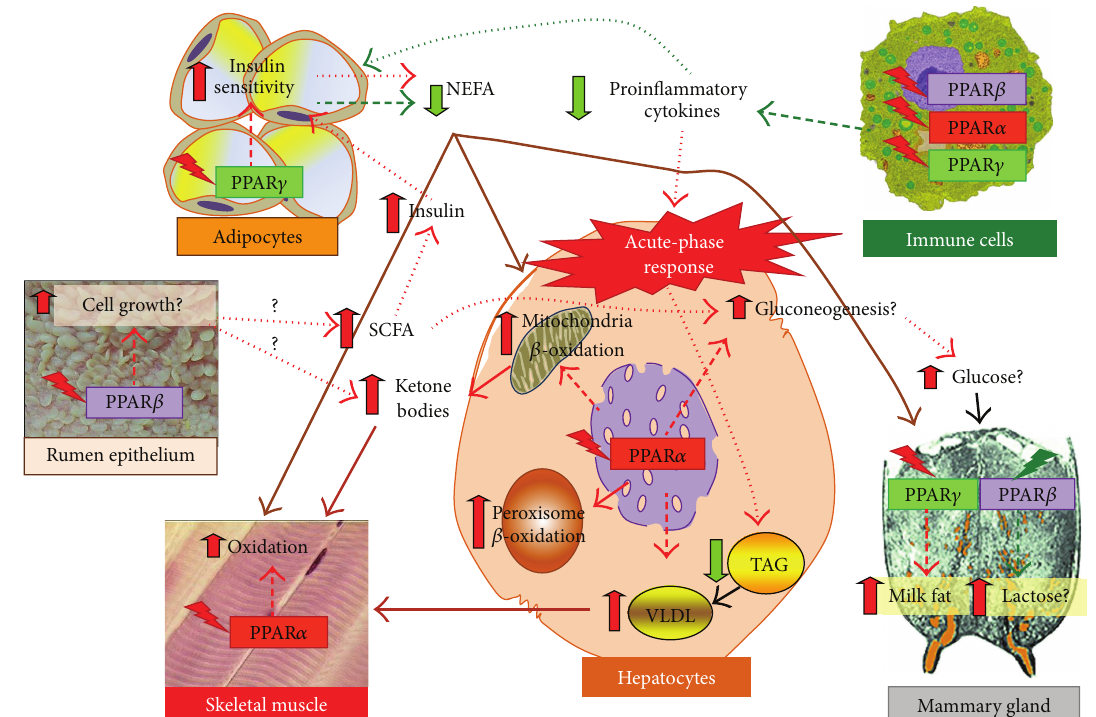
Figure 4: Improving transition from pregnancy into lactation in high producing dairy cows by nutrigenomics approach through PPAR isotypes: a hypothesis. The liver buffer cells from the excessive concentration of circulating nonesterified fatty acids (NEFA) by both catabolizing long-chain fatty acids (LCFA) with production of ketone bodies (KB) and esterifying them as triacylglycerol (TAG). The TAG are then accumulated in lipid droplets and packed into VLDL for release into the bloodstream. The liver is also induced by proinflammatory cytokines to produce positive acute phase proteins (+APP) taking away hepatic resources for normal liver functions. Despite the decrease in peripheral insulin concentration postpartum, the activation of PPAR 𝛾 prior to parturition can decrease NEFA postpartum through greater insulin sensitivity primarily on the adipose tissue. The activation of PPAR 𝛽 / 𝛿 (PPAR 𝛽 in the figure) via LCFA can increase rumen epithelium growth with consequent larger production of short-chain fatty acids (SCFA) including propionate, which stimulate insulin production, and butyrate,augmentingtheKBinblood. TheincreasedactivationofPPAR 𝛼 justbeforeparturitionandduringthefirst14dayspostpartuminthe liver and muscle can increase NEFA oxidation with greater proportion of KB produced per amount of NEFA uptake. The activation of PPAR 𝛼 intheliverhasthepotentialtoincreasegluconeogenesisandVLDLsynthesis.TheKBcanserveasfuelsbyskeletalmuscleinsteadofNEFAand glucose; both molecules are substrates for mammary gland. In this tissue, the activation of PPAR 𝛾 postpartum should increase or maintain milk fat. In addition, the inhibition of PPAR 𝛽 / 𝛿 postpartum can potentially increase glucose import with a consequent increase in lactose synthesis, and hence, milk yield. The activation of PPAR isotypes just prior to parturition and during the first two weeks post-partum should diminish the inflammatory-like conditions preventing, on one hand, the stimulation of NEFA release and, on the other hand, hepatic acute- phase reaction, both determined by proinflammatory cytokines. This coordinated set of reactions should provide an ideal metabolic situation leading to a smoother transition from pregnancy into lactation, that is, allow the liver to allocate its resources for “normal” functions. As a consequence of this, the incidence of diseases typical of the peripartal period would be reduced, and hence, cows with higher performance and more healthy. Regular dashed arrows represent “effect on” due to PPAR isotype activation/inhibition, and round dot arrows denote secondary (or indirect) effects of PPAR isotype activation. In both cases red = activation or increase and green = inhibition or